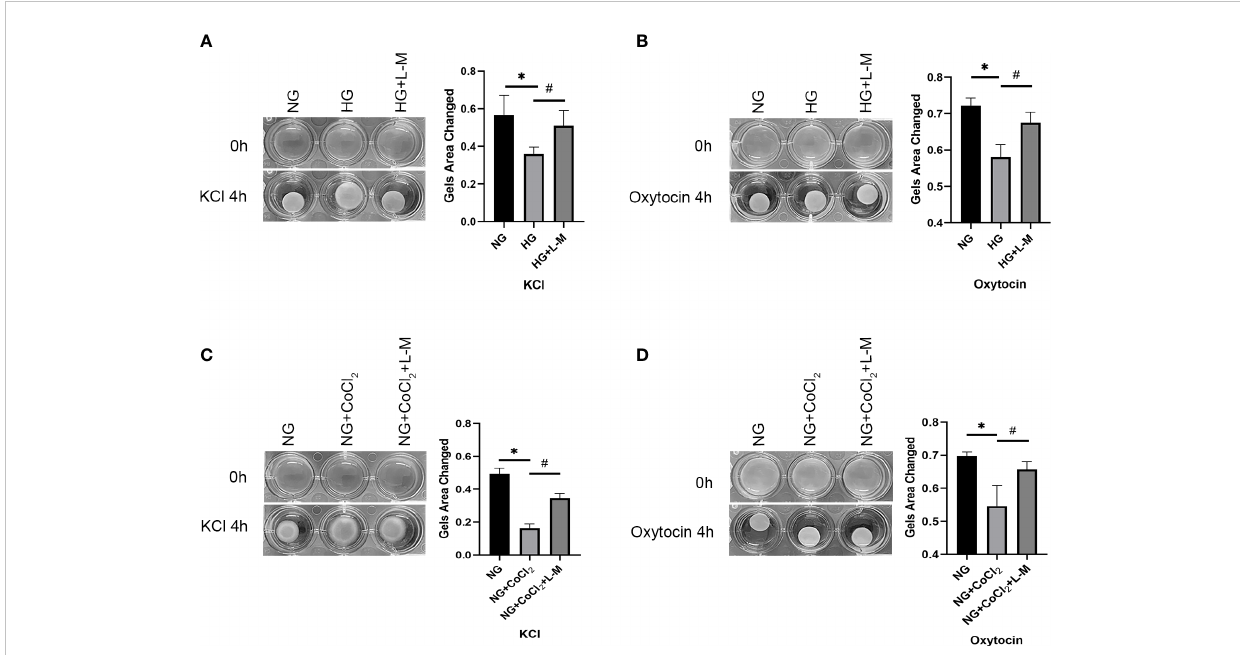
FIGURE 7 TREK1 inhibitor L-methionine increased the HUSMC contractility decreased by high glucose levels or hypoxia. We divided HUSMCs into the normal glucose (NG, 5.5 mmol/L) group, high glucose (HG, 25 mmol/L) group, high glucose with L-methionine (HG+L-M) group, normal glucose with CoCl 2 (NG+CoCl 2 ) group, and normal glucose + CoCl 2 with L-methionine (NG+CoCl 2 +L-M) group in a 24-well culture plate. The medium was added after collagen polymerization (0 h). The images of collagen stimulated by KCl (A) or oxytocin (B) for 4 h. The contraction of HUSMCs was assessed by measuring the mean gel area change. The medium was added after collagen polymerization (0 h). The images of collagen stimulated by KCl (C) or oxytocin (D) for 4 h. The contraction of HUSMCs was assessed by measuring the mean gel area change. Data are presented as means ± SEM, n = 4 for each group. (A, B) * means HG vs. NG and P<0.05. (A, B) # means P<0.05 HG+L-M vs. HG and P<0.05. (C, D) * means P<0.05 NG+CoCl 2 vs. NG and P<0.05. (C, D) # means P<0.05 NG+CoCl 2 +L-M vs. NG+CoCl 2 and P<0.05. HUSMCs, human uterine smooth muscle cells; SEM, standard error of the